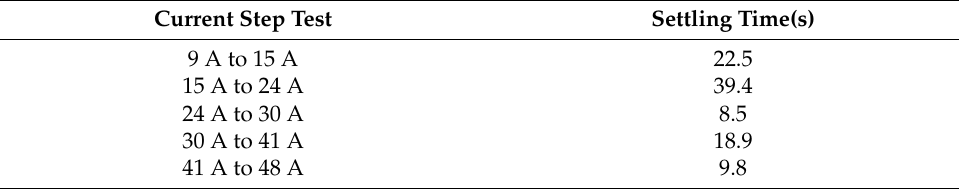
Figure 5. Humidity dynamics under different current conditions. Table 1. The settling time of the internal humidity under such current step tests.